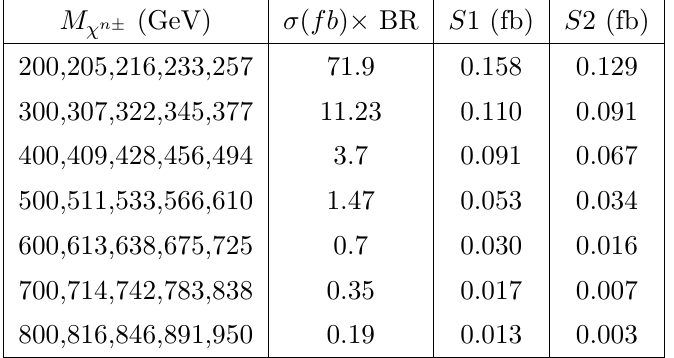
Table 6 . Signal cross-sections after passing the various selection criteria in the 3SSL channel at the 13 TeV LHC for di(cid:11)erent masses of the quintuplet. Here n runs from 0 to 4 in a given quintuplet. We consider BR( (cid:31) Q +1 l(cid:23)(cid:31) Q ) = 0.22 where l = e; (cid:22) and BR( (cid:31) Q +1 !